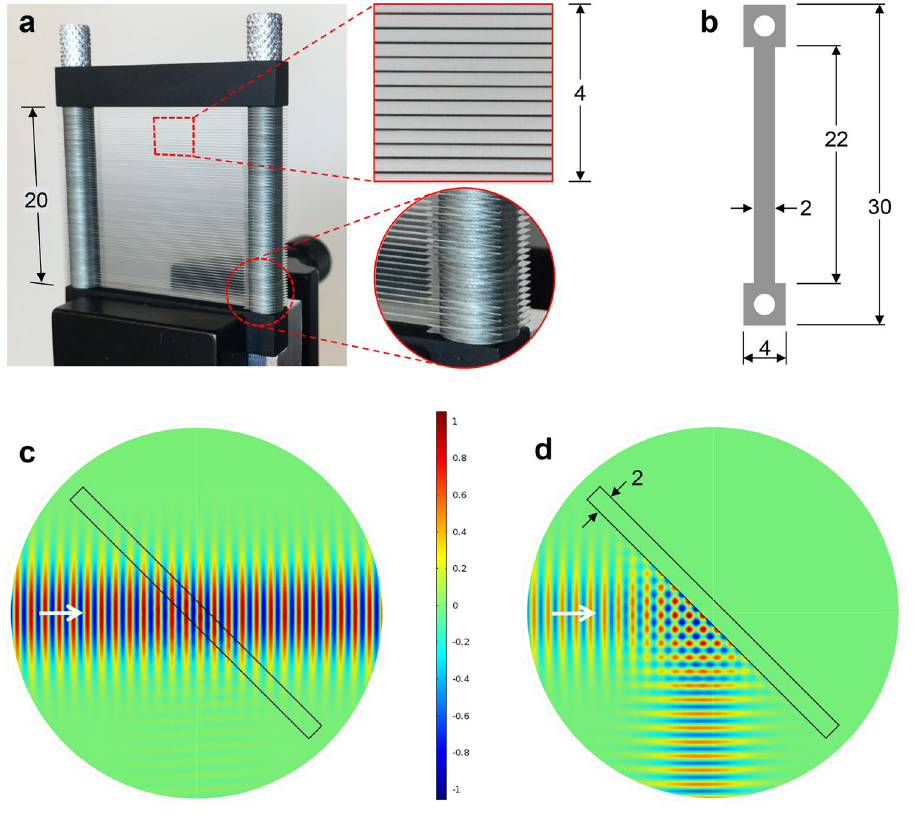
Figure 1. Fabricated device and simulations. ( a ) Photograph of the PBS device with close-up views showing a square section of the stack-of-plates (looking on axis) and the bottom-corner of the mounting post. ( b ) Geometry of a single stainless-steel plate. ( c , d ) FEM simulations of the beam propagation at a frequency of 0.2 THz when the input electric field is linearly polarized ( c ) perpendicular, and ( d ) parallel, to the plates. The beam diameter is 1 cm and the angle of incidence is 45°. All dimensions are in